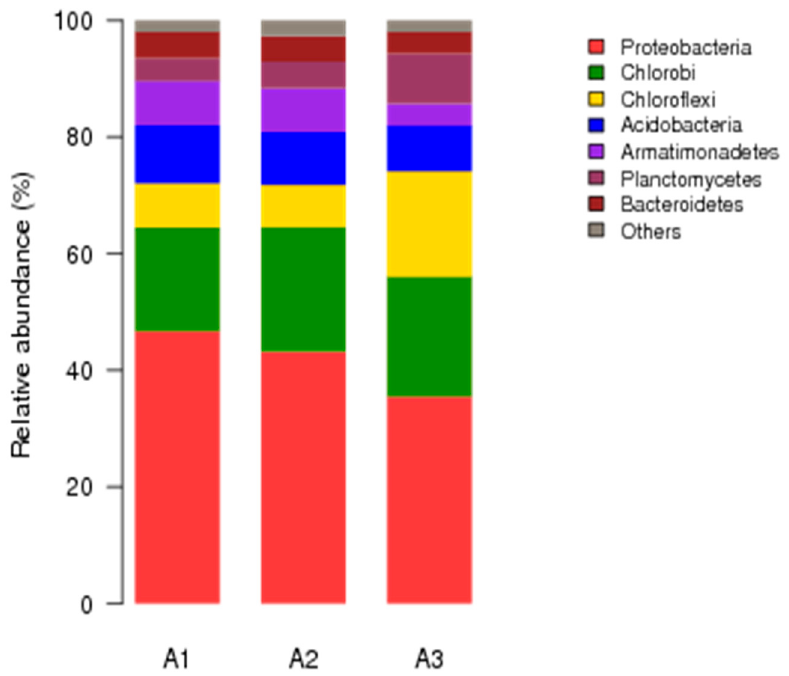
Figure 4. Relative abundance of major phyla in samples collected on day 1 ( A1 ), day 13 ( A2 ), and day 79 ( A3 ).